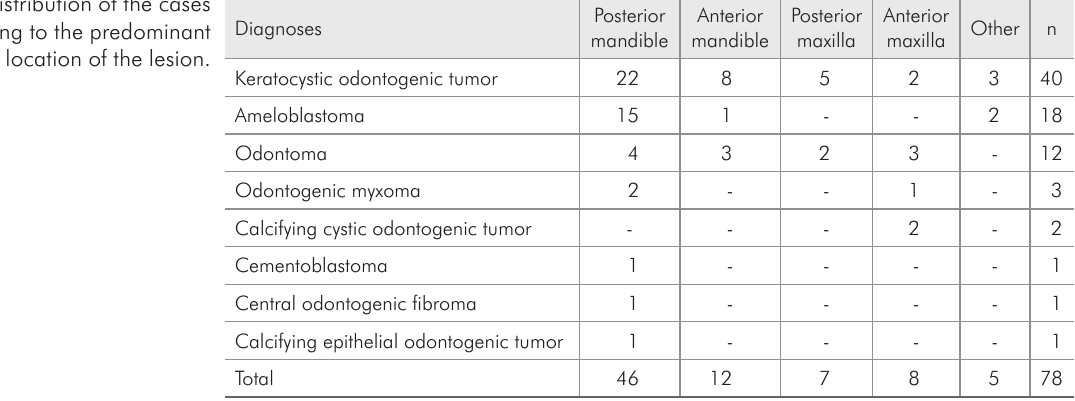
Table 4 - Distribution of the cases according to the predominant location of the